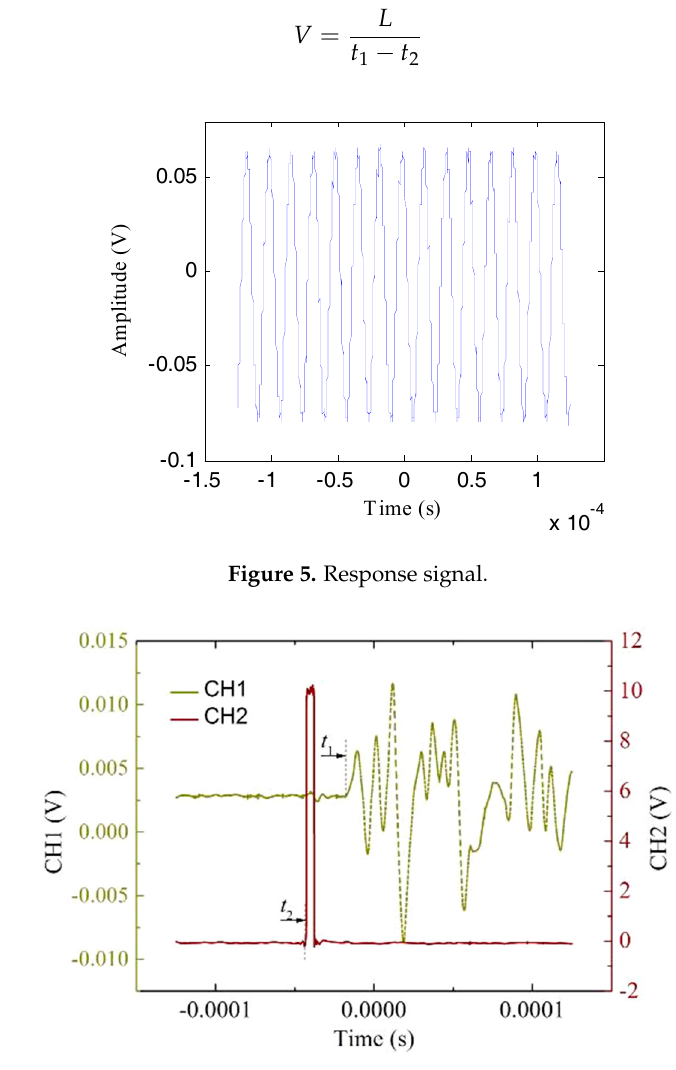
Figure 6. Typical pulse drive (CH2) and sensing (CH1) signals [22].